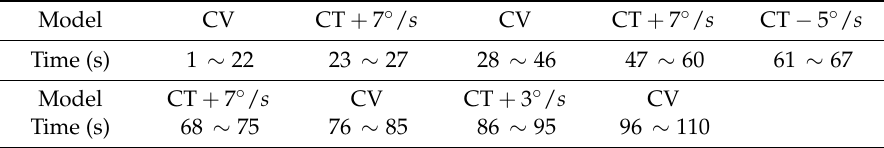
Figure 9. The target’s true trajectory and motion scenario. Table 2. Motion models and durations of the target’s